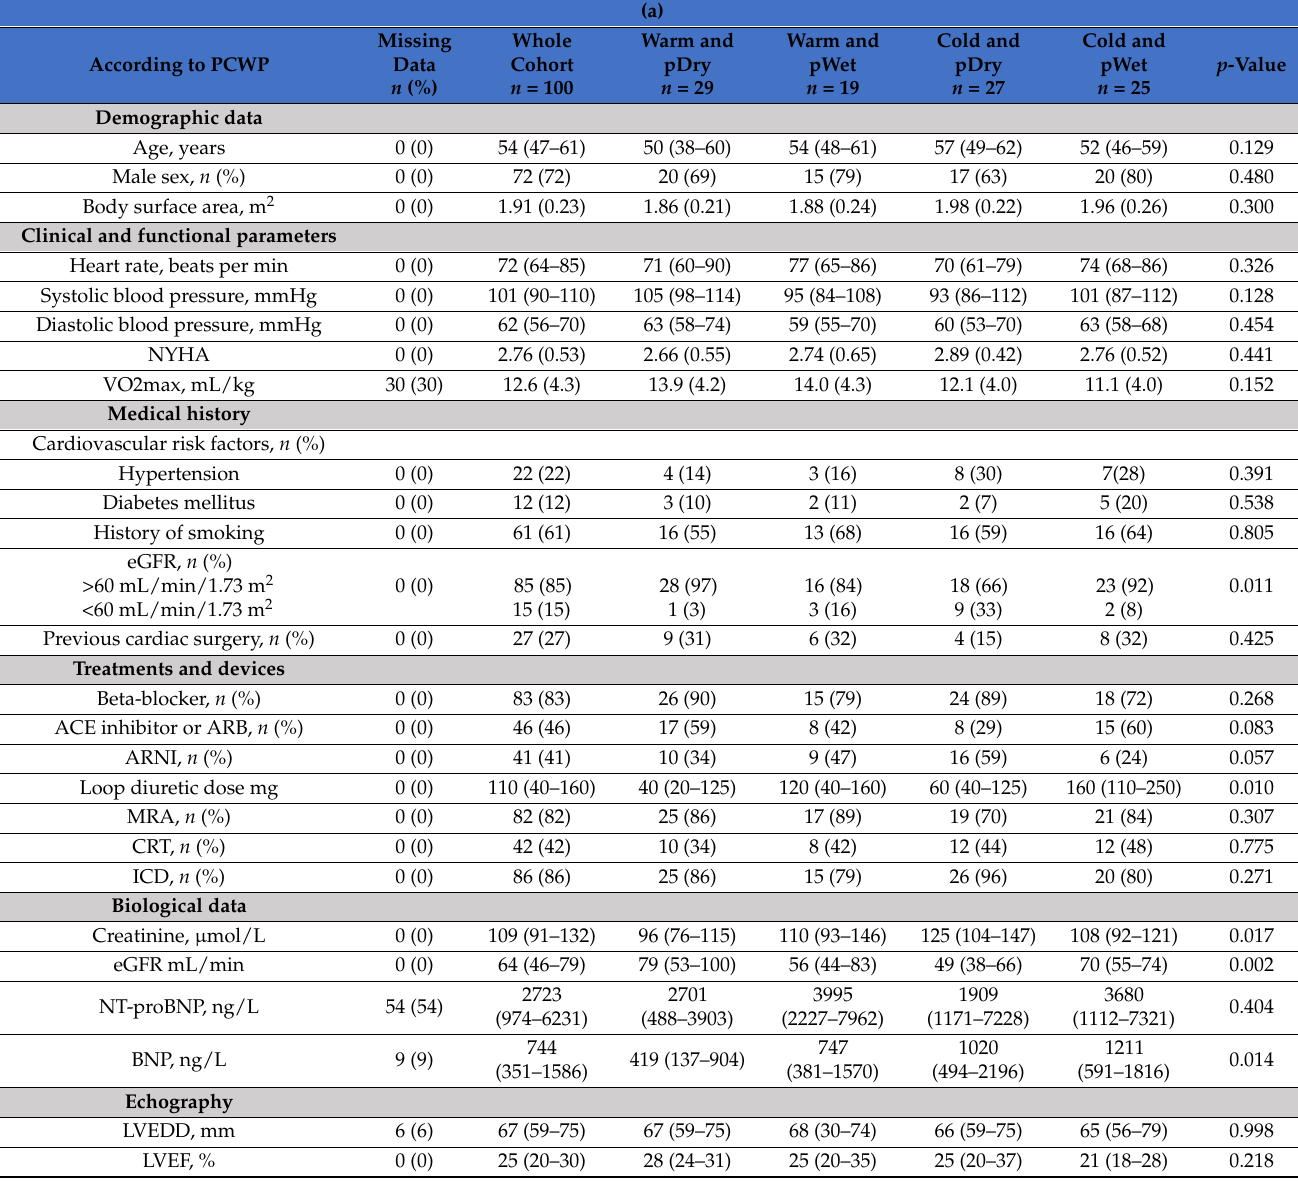
Table 1. Baseline patient characteristics, medication use, and hemodynamic variables for groups according to PCWP and